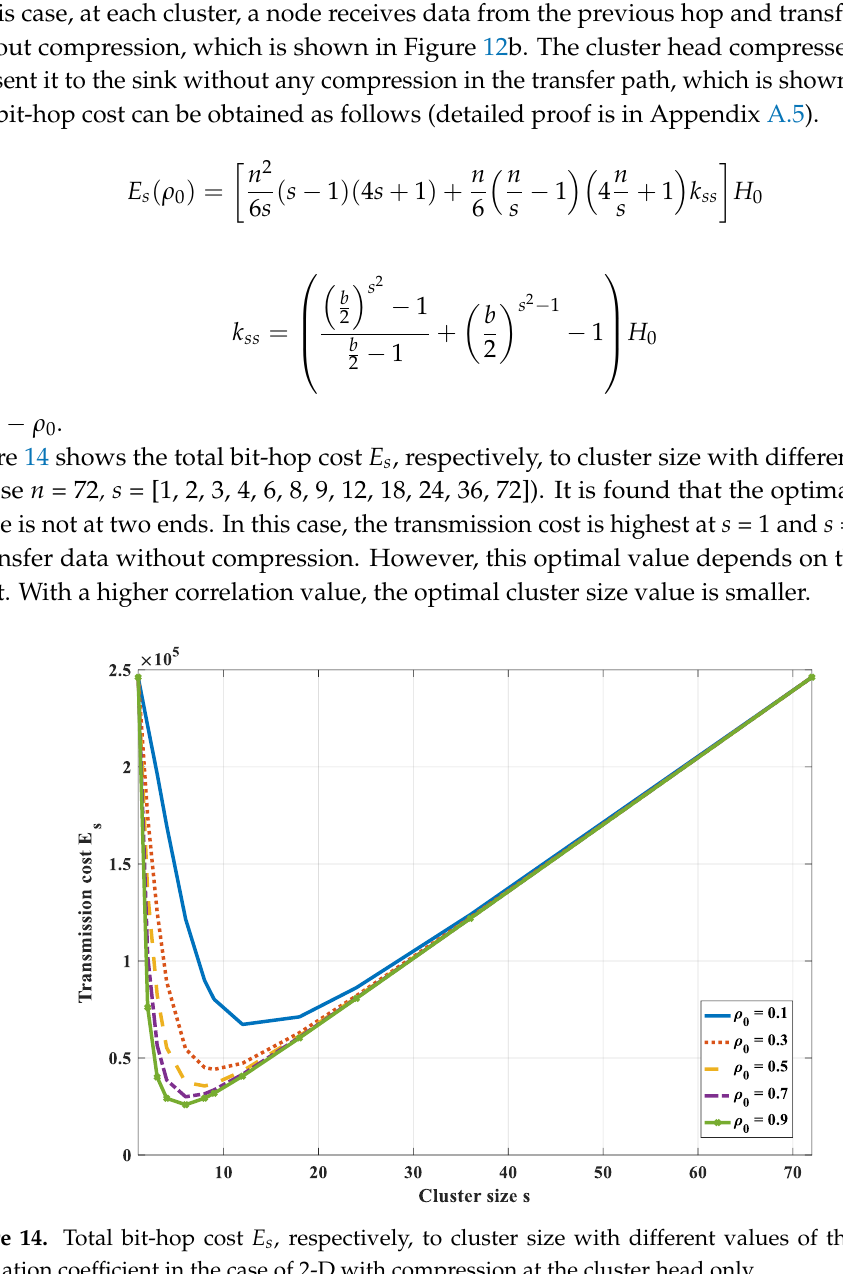
Figure 15. Illustration of clustering for a general topology model. Same as in Section 4.1.2, the network is assumed to be deployed in an n × n area. Nodes are deployed randomly over the network area. The network then can be divided into the correlated region with of size s × s . In this simulation, we choose the network size of 48 m × 48 m ( n = 48), density of deployment is 1 node/m 2 , and s = [1, 2, 3, 4, 6, 8, 12, 16, 24, 48] . We also assumed that the energy